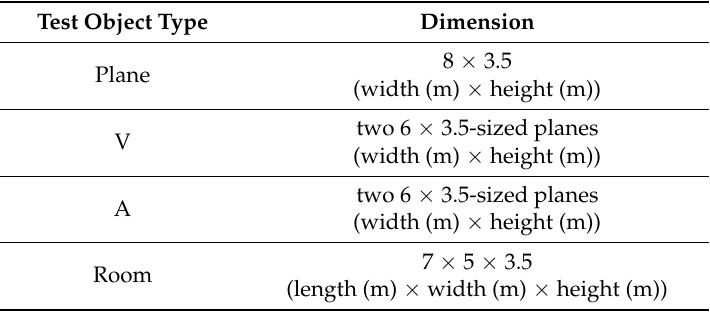
Table 2. Dimensions of the test objects considered.